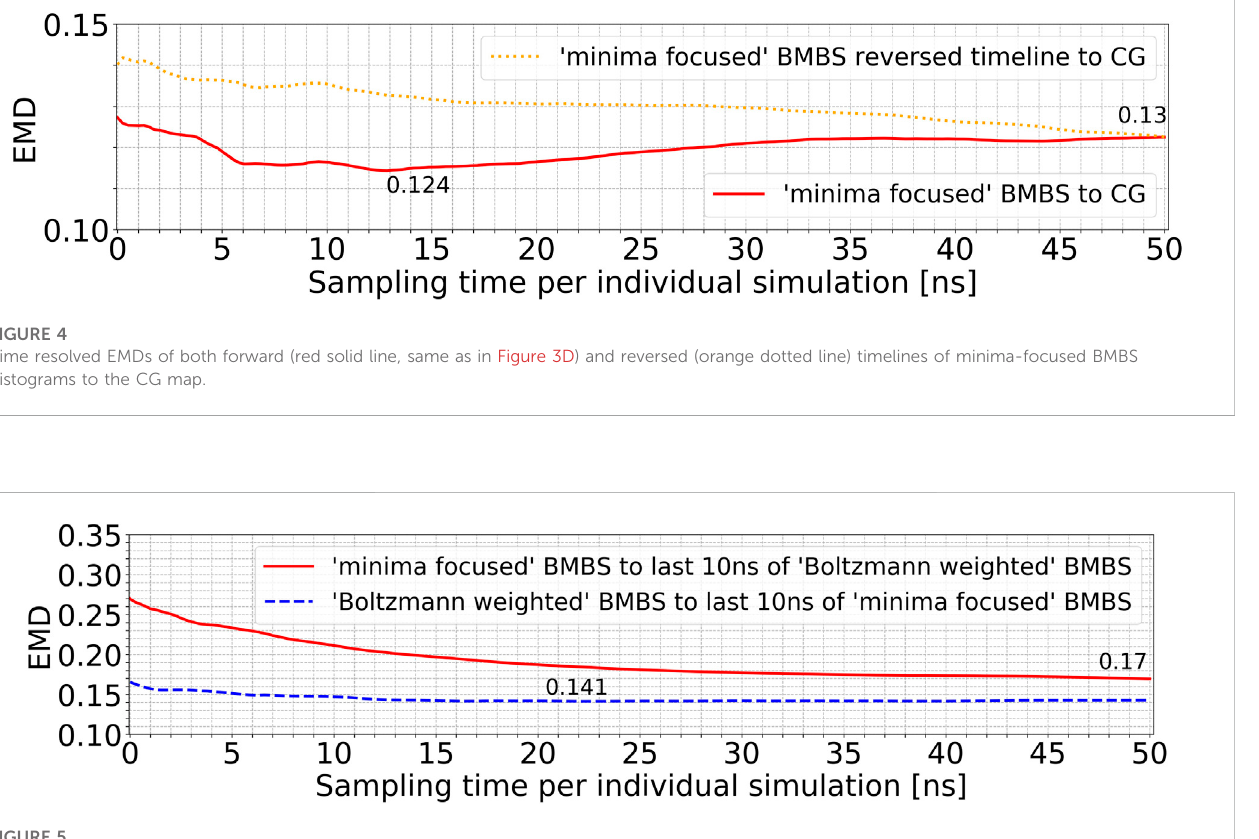
FIGURE 5 EMDsoftheentiretrajectoriesoftheminima-focusedseedingtothehistogramofthelast10 nsoftheBoltzmann-weightedseeding(redcurve)andvice versa (blue